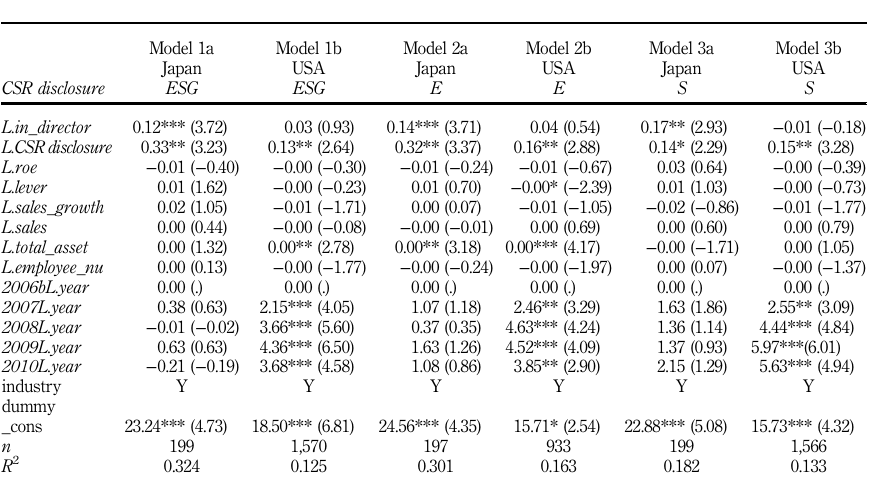
Table II. Correlation matrix for all firm-year observations